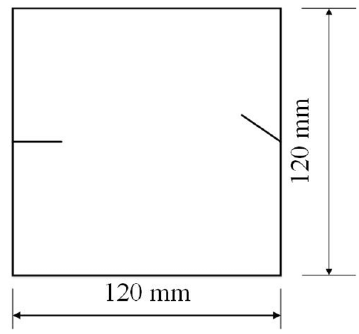
Figure 32. Specimen with two 30 mm long cracks.